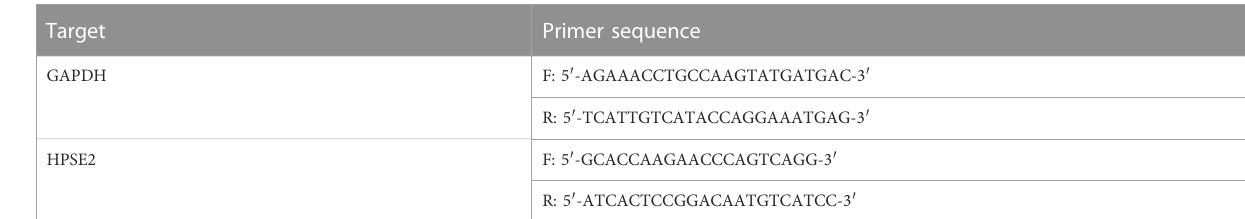
TABLE 1 Primers used in real-time PCR.